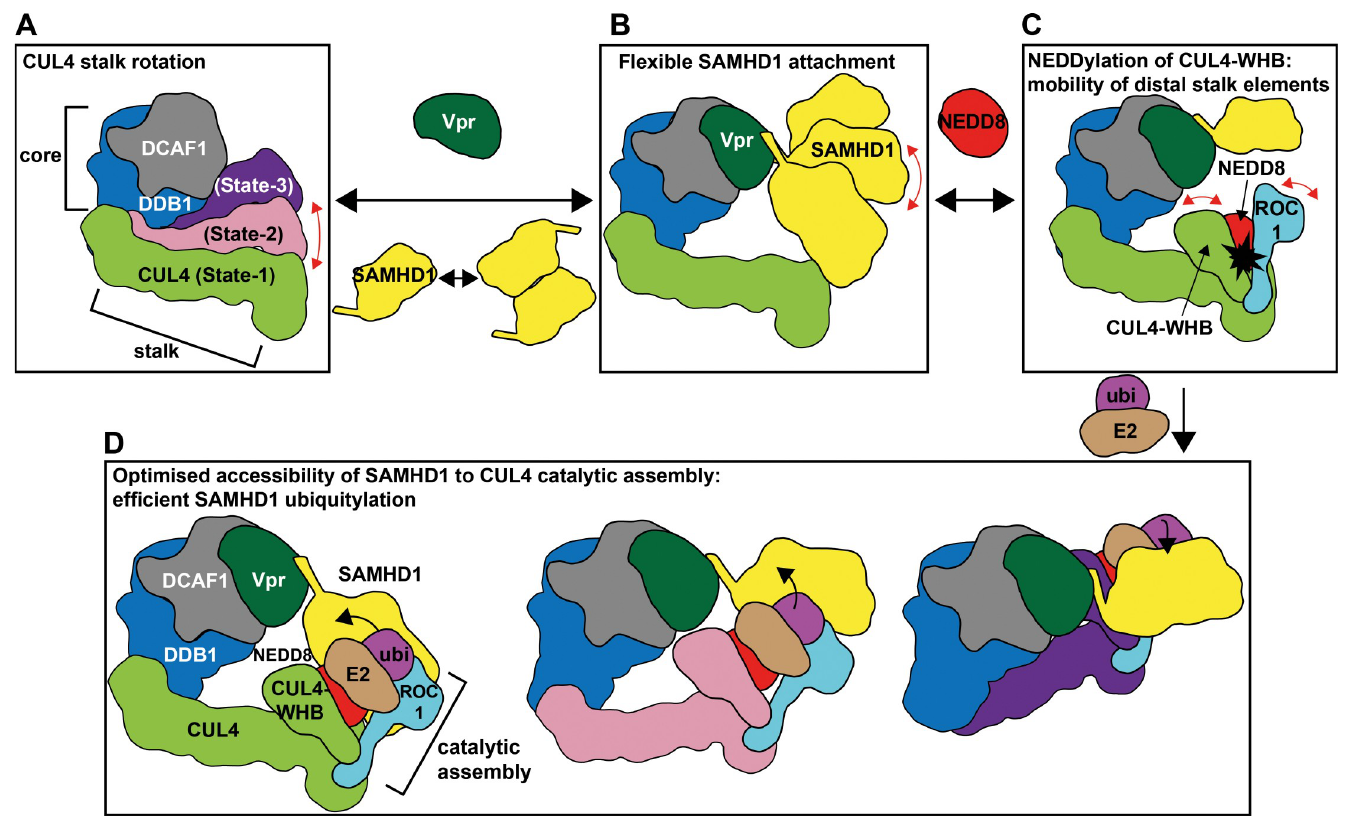
Fig 7. Schematic illustration of structural plasticity in Vpr mus -modified CRL4 DCAF1-CtD , and implications for ubiquitin transfer. ( A ) Rotation of the CRL4 stalk increases the space accessible to catalytic elements at the distal tip of the stalk, forming a ubiquitylation zone around the core. ( B ) Flexible tethering of SAMHD1 to the core by Vpr mus places the bulk of SAMHD1 in the ubiquitylation zone and optimises surface accessibility. Under the experimental conditions, SAMHD1 adopts a monomer-dimer equilibrium, with both forms being competent for Vpr-binding. In B - C , only monomeric SAMHD1 is schematically indicated for clarity. ( C ) Modification of CUL4-WHB with NEDD8, triggered by substrate binding, leads to increased mobility of these distal stalk elements (CUL4-WHB, ROC1 RING domain) [56], further extending the ubiquitylation zone and activating the formation of a catalytic assembly for ubiquitin transfer (see also D ) [72]. ( D ) Dynamic processes A - C together create numerous possibilities for assembly of the catalytic machinery (CUL4-NEDD8 WHB, ROC1, ubiquitin-(ubi-)charged E2) on surface- exposed SAMHD1 lysine side chains. Here, three of these possibilities are exemplified schematically. In this way, ubiquitin coverage on SAMHD1 is